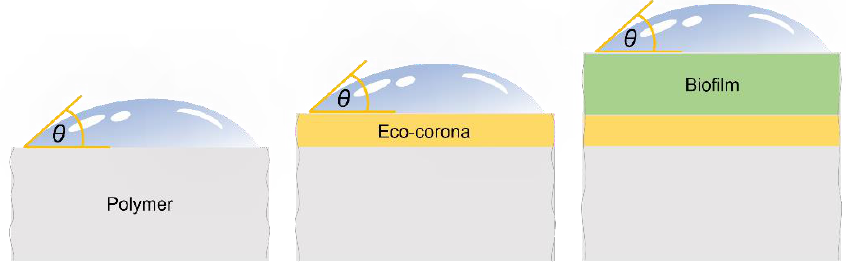
Figure 1. Schematic representation of surfaces resulting from the weathering of polymers: polymer surface, weathered by photooxidation, hydrolysis, or biodegradation, eco-corona layer, and biofilm layer. The outer layer is decisive for the measurement of wettability.